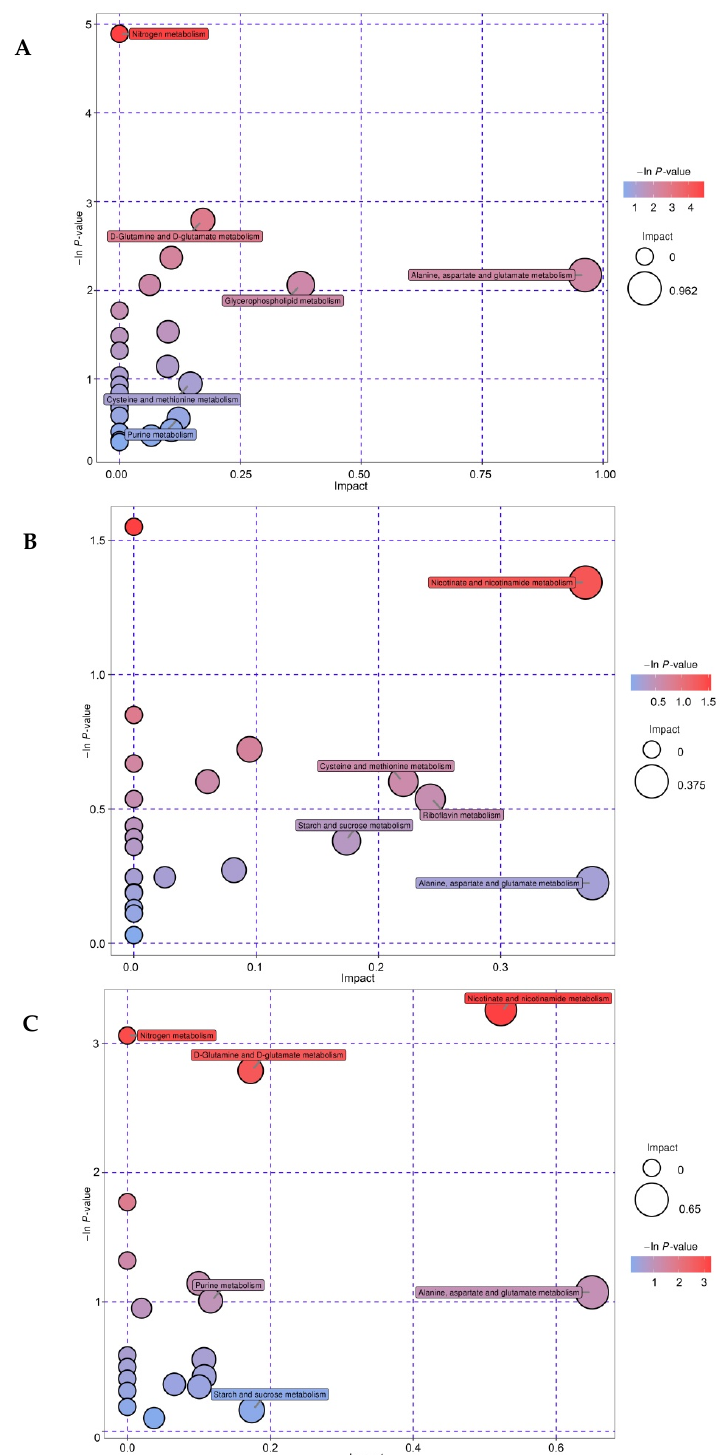
Figure 7. Enrichment analysis of differential metabolites. Each bubble in the bubble chart represents a metabolic pathway. The abscissa and size of the bubble indicate the influence of the factor on the pathway in the topology analysis. The p value of the enrichment analysis is presented as a bubble color in the bubble ordinate. A darker color results in a smaller p value and a more significant degree of enrichment. ( A – C ) are bubble plots of M1 vs. S1, M20 vs. S20, and M40 vs. S40. Abbreviations: M, mixed-fermentation cheese; S, single-strain-fermentation cheese. Numbers 1–40 represent different ripening times (in days).